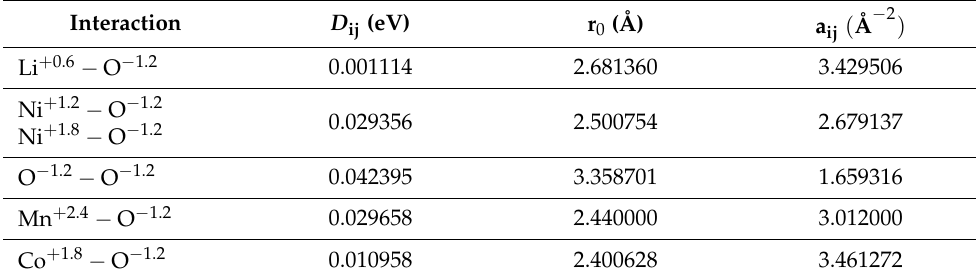
Table 1. Potential function